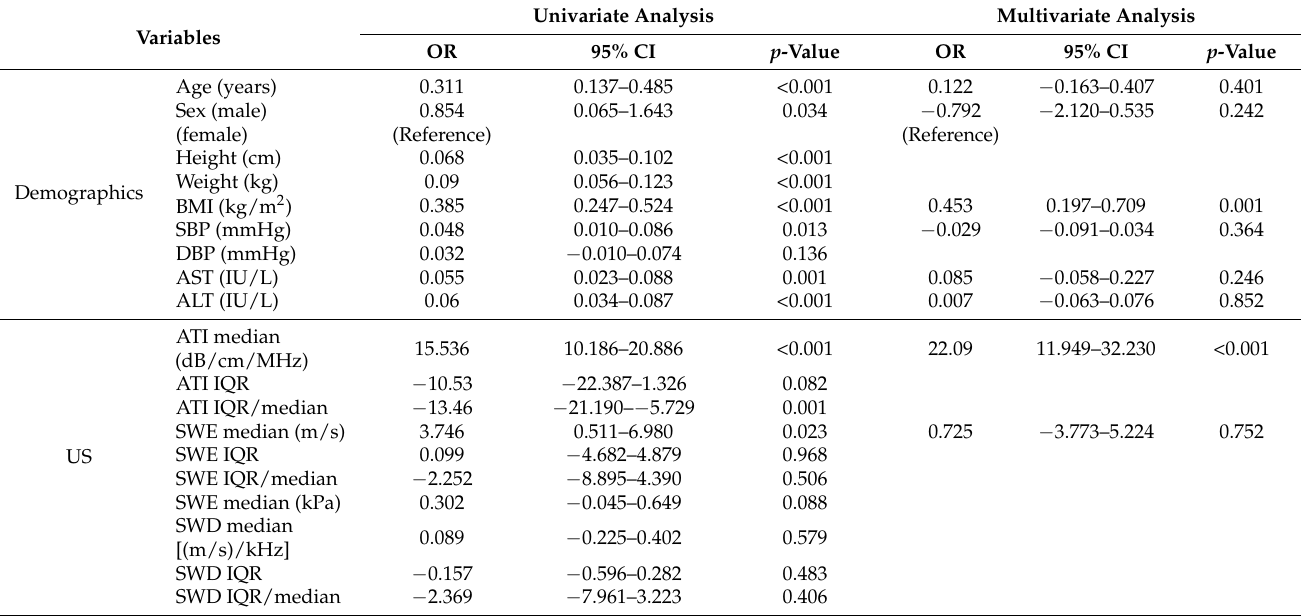
Table 2. Results of the ordinal logistic regression analysis for the three fatty liver groups (normal, mild, and moderate–severe) according to grayscale